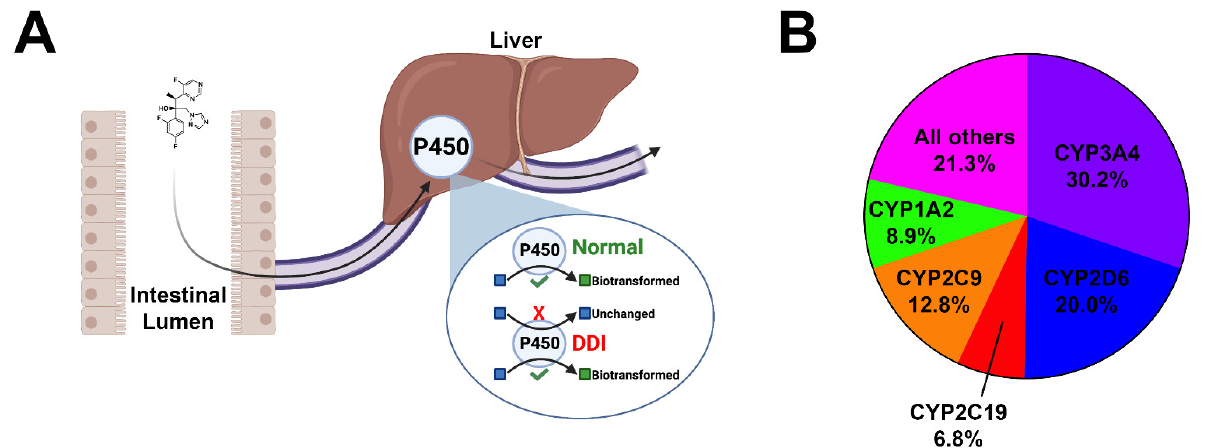
Figure 1. Cartoon depiction of cytochrome inhibition and pie chart. ( A ) Orally bioavailable drugs are absorbed from the intestinal lumen into the mesenteric capillaries and transported to the liver via the portal vein. Many drugs undergo phase I biotransformation by major cytochromes within hepatocytes. This process enzymatically converts lipid-soluble compounds to more water-soluble compounds to facilitate the excretion. In the event of polypharmacy and/or the co-administration of CYP inhibitors, serum accumulation of unmetabolized drugs may occur, leading to untoward toxicities. ( B ) Pie chart demonstrating the breakdown of the five major cytochromes and their contributions to the oxidative metabolism of xenobiotics and organic endogenous molecules.